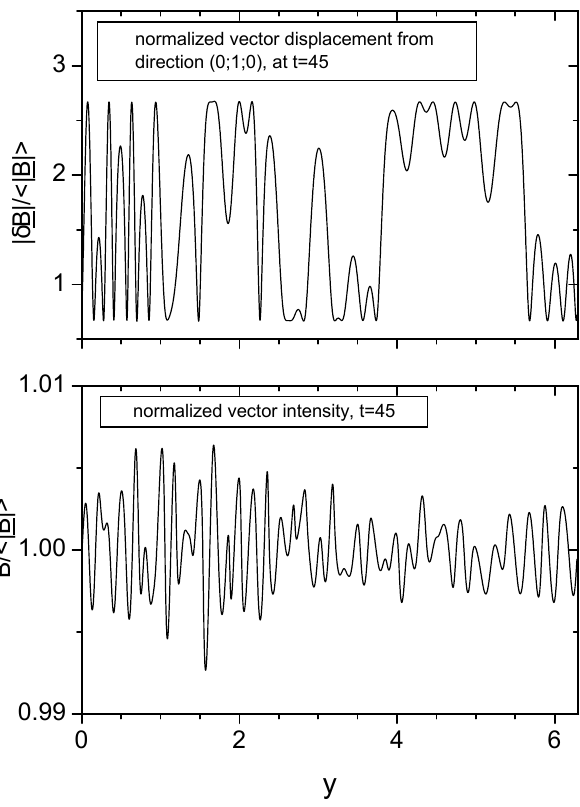
Fig. 18. Results of the numerical simulations of the parametric instability at time t = t 1 = 45 τ A . Normalized vector displacements versus the spatial coordinate y are shown in the top panel, while normalized vector intensities are shown in the bottom panel. This figure should be compared with Fig. 6. The top panel shows large fluctuations which are basically uncorrelated with the profile of the magnetic field intensity in the bottom panel. This behaviour is qual- itatively similar to that observed in the fast wind at 0.3AU (see Fig. 6)